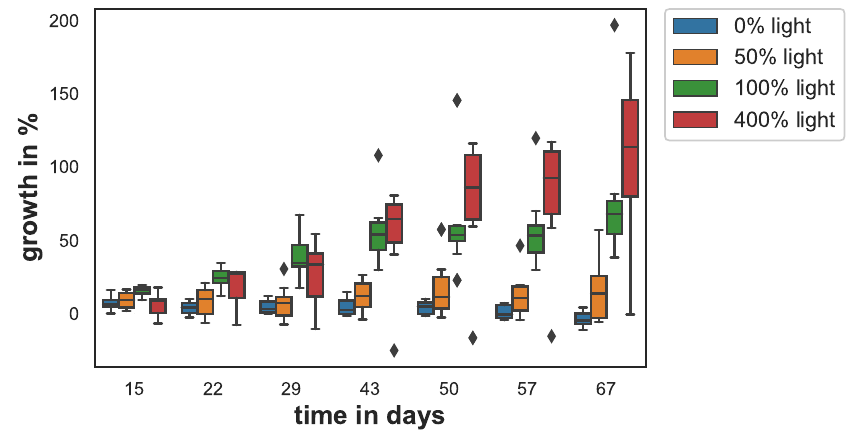
Figure 2. Sponge growth in percent area increase with respect to initial area over the course of the experiment. The box shows the quartiles of the dataset while the whiskers show the rest of the distribution, except for outliers that are plotted as